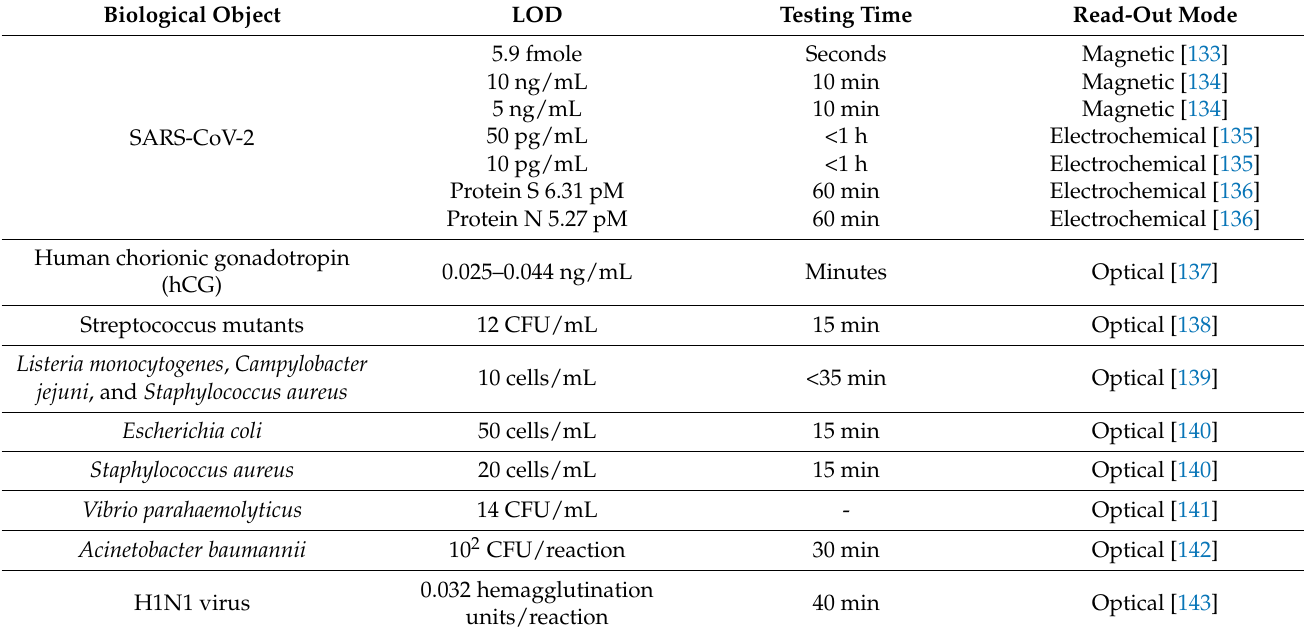
Table 1. Comparative table of the limit of detection (LOD) of biological objects detected via MNPs with specified read-out